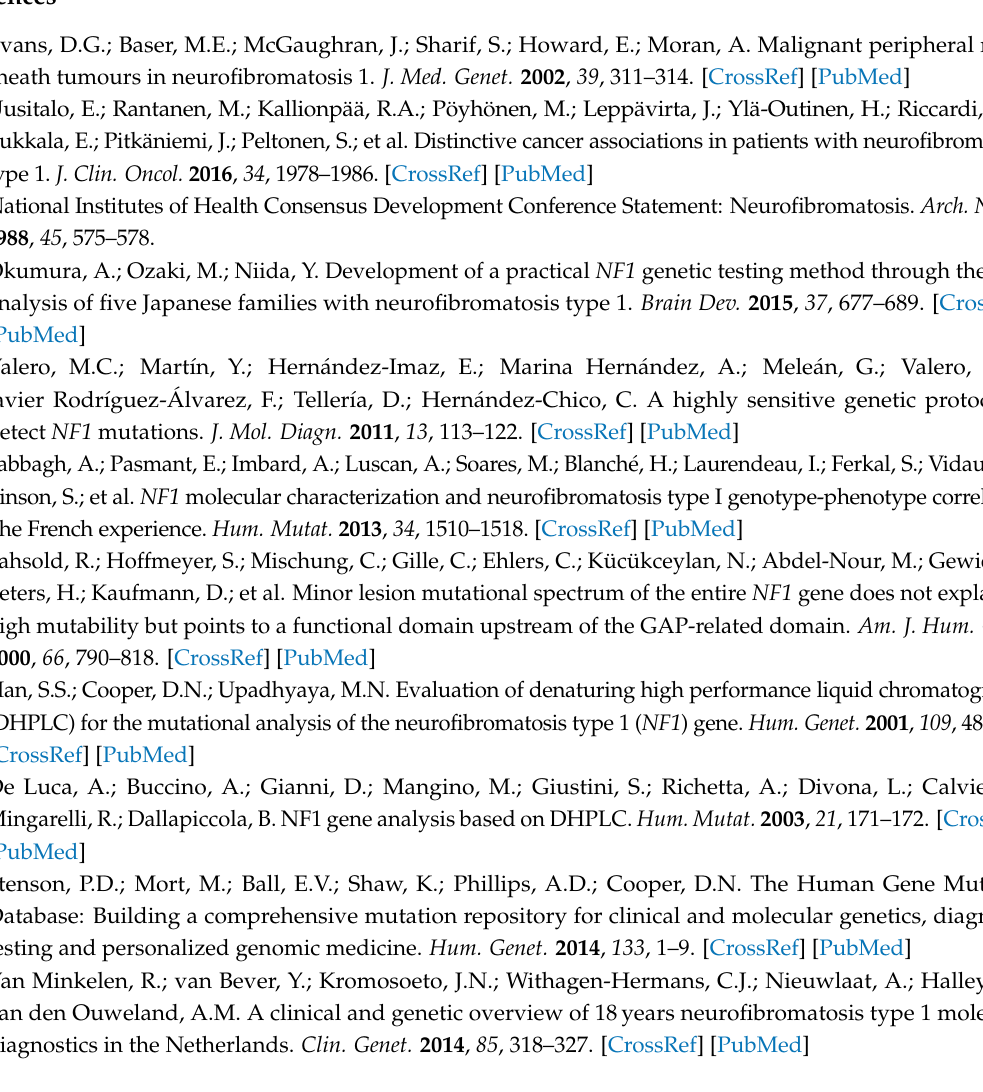
s1, Table S1: List of non-neutral variants identified in this study, Table S2: Tabular data relative to Figure 5. Supplementary references for in silico tools used in this